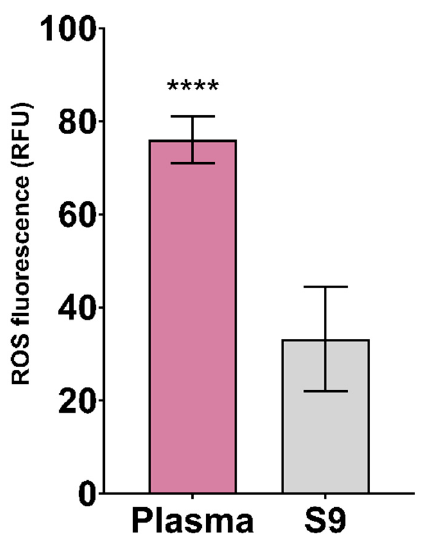
Figure 6. Relative fluorescence (RFU) of the reactive oxygen species (ROS) in plasma and S9 of white stork ( C. ciconia ) nestlings ( n = 16), presented as the mean ± SD. Statistical difference is indicated with **** (Welch’s t-test, p < 0.0001).